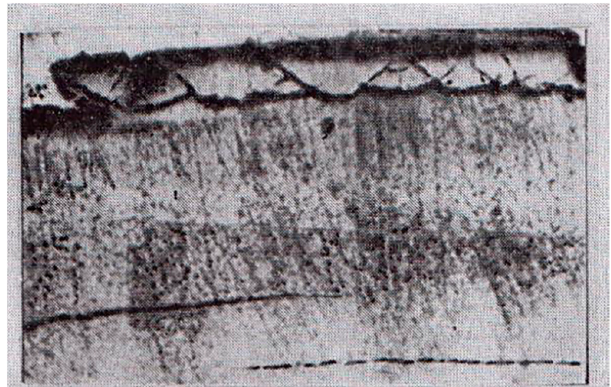
Figure 7. Cross microsection of sample CB-60. Table 5. DCS indicators of sample CB-60.